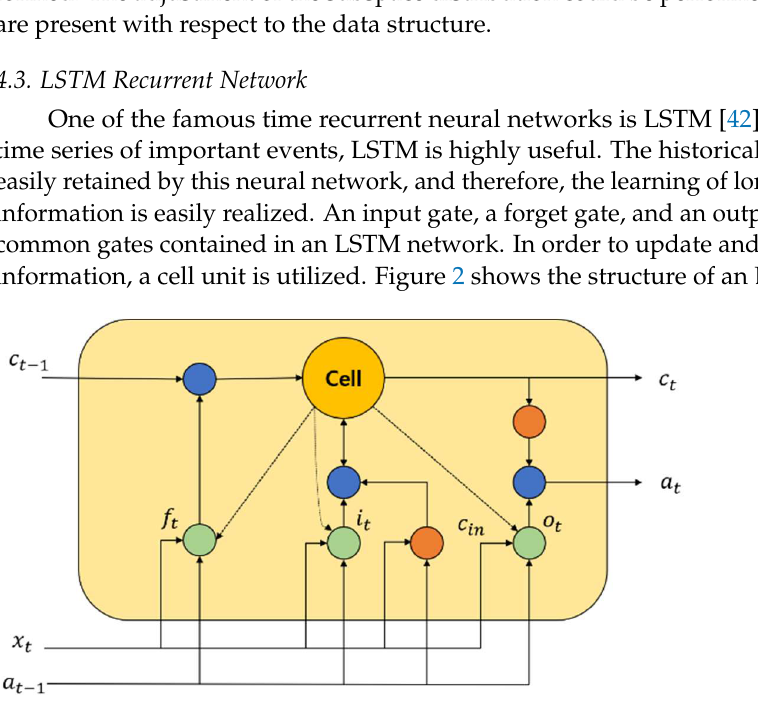
Figure 2. An LSTM representation.